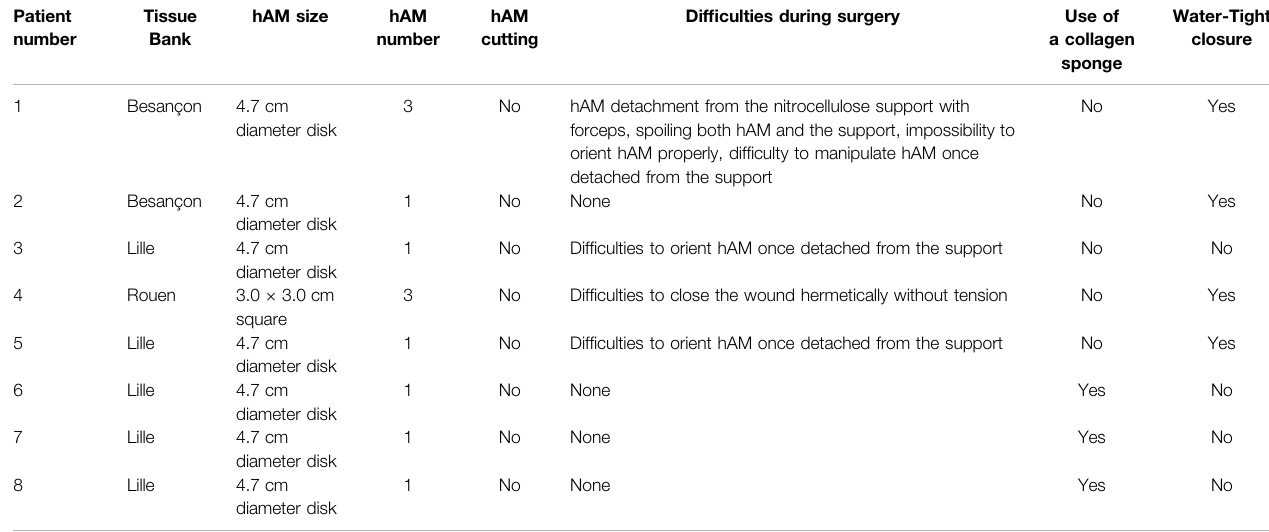
TABLE 2 | hAM and surgical data. Patient number